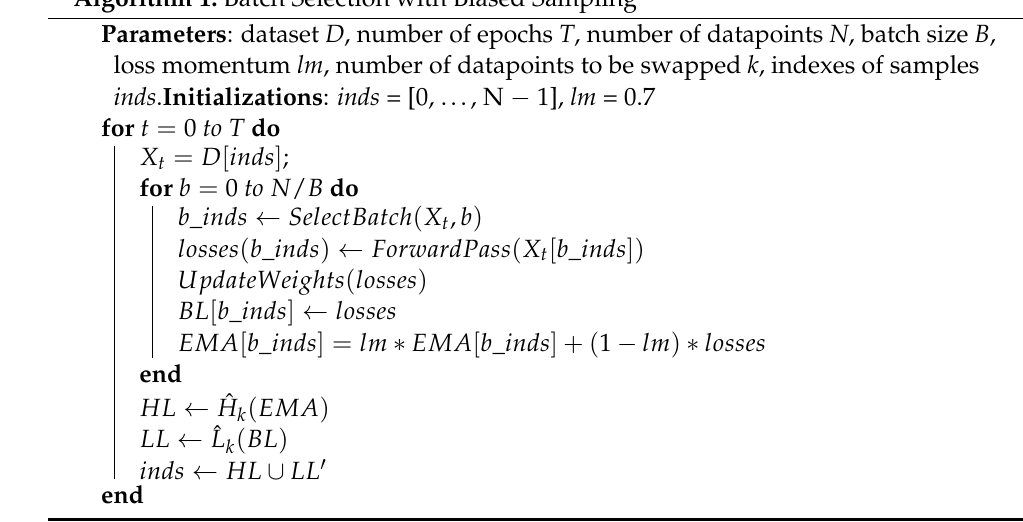
Algorithm 1: Batch Selection with Biased